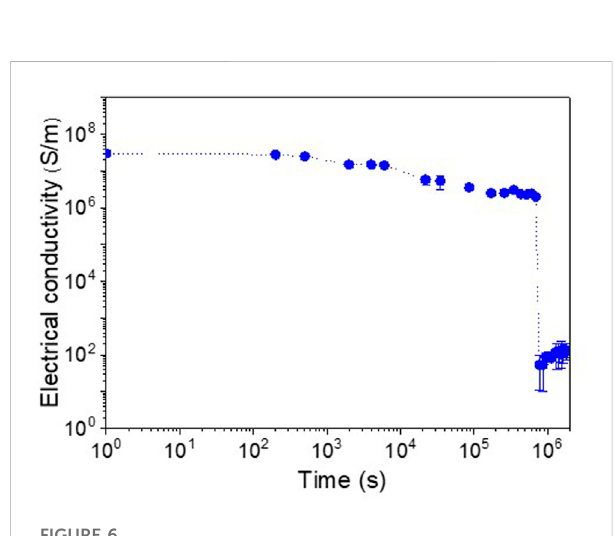
FIGURE 6 Electrical conductivity of the partly gold-coated SCCY as a function of immersion time in a 1 M NaCl solution at 60 ° C.